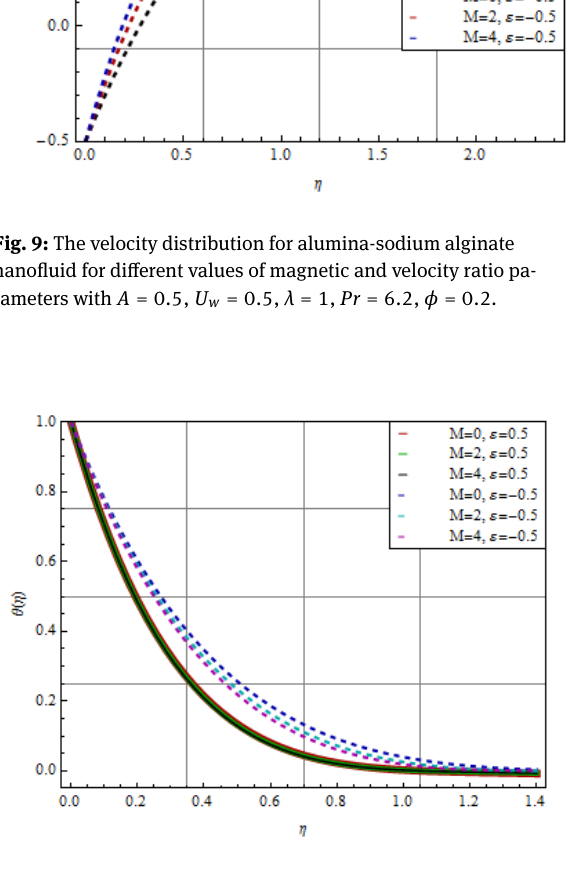
O and TiO nanoparti- 2 3 2